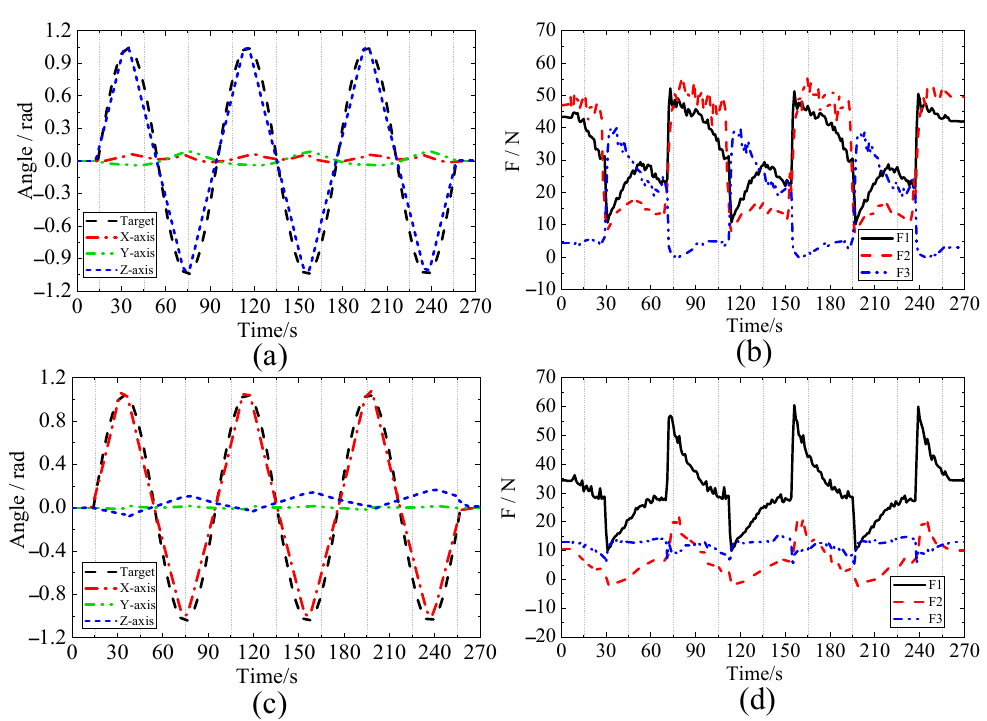
Figure 12. Test results of the single-joint group. ( a , b ) Vertical sinusoidal trajectory and cable force and ( c , d ) horizontal sinusoidal trajectory and cable force.